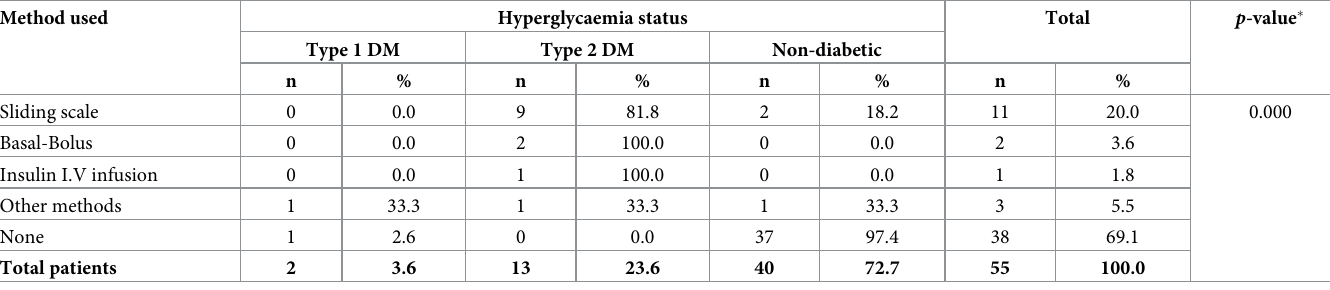
Table 3. Hyperglycaemia control methods by the glycaemic status of the patients (n =